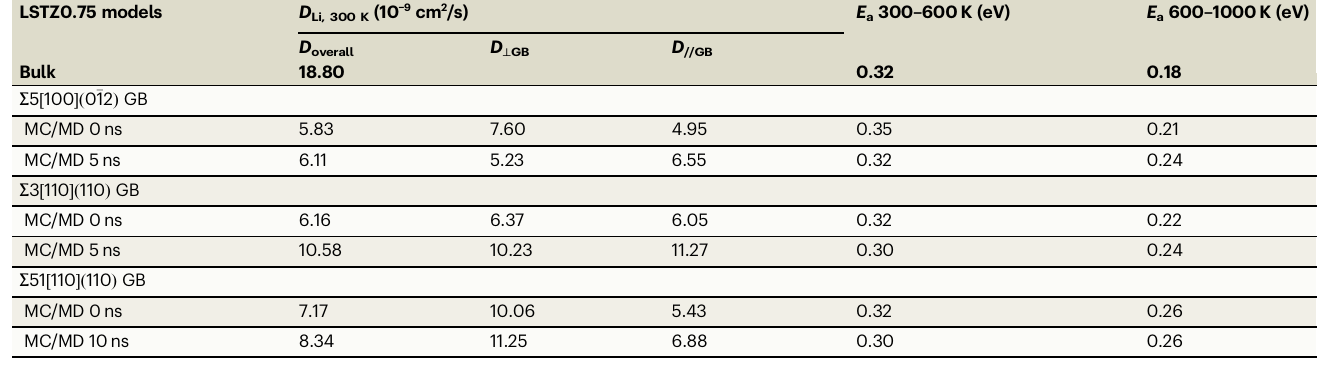
Table 2 | Activation energies ( E a ) and Li diffusivities at 300 K ( D Li, 300 K ) of bulk LSTZ0.75 and at the GB regions of the three GB orientations before and after MC/MD simulations at 1573 K LSTZ0.75